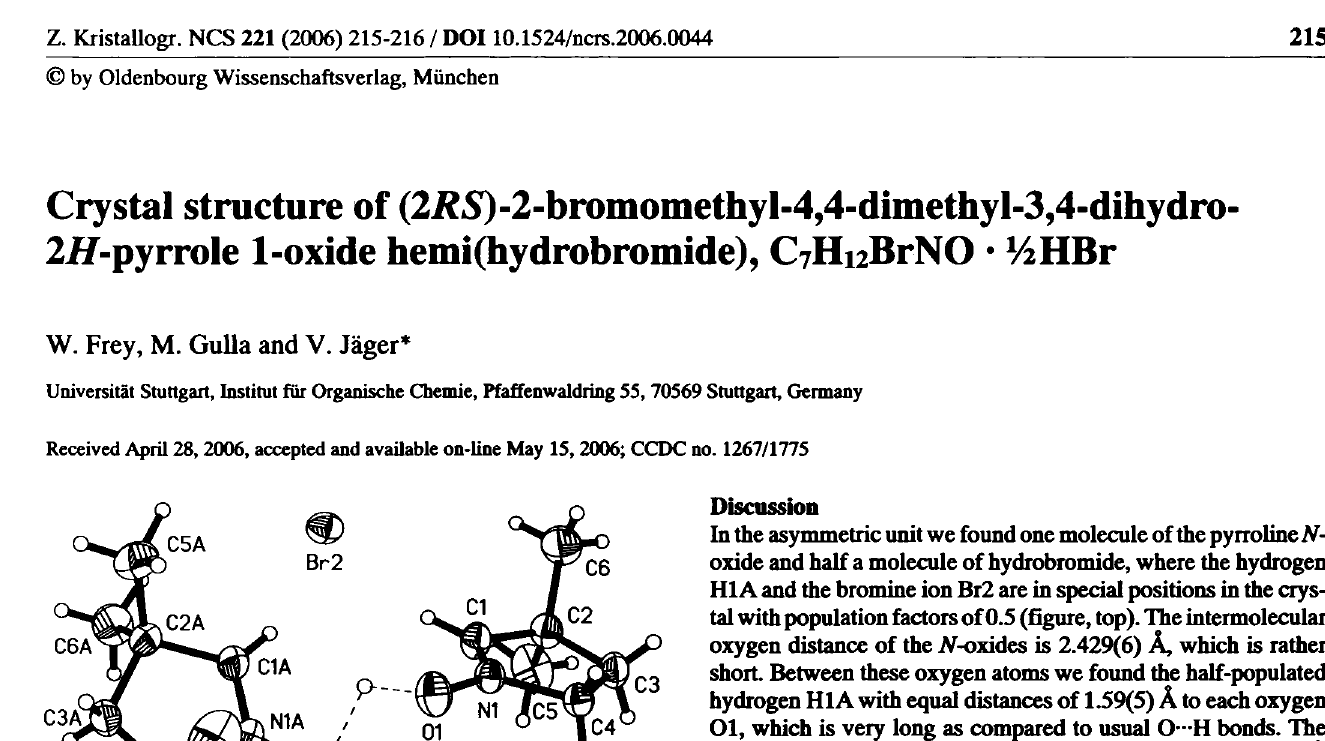
Table 1. Data collection and handling.